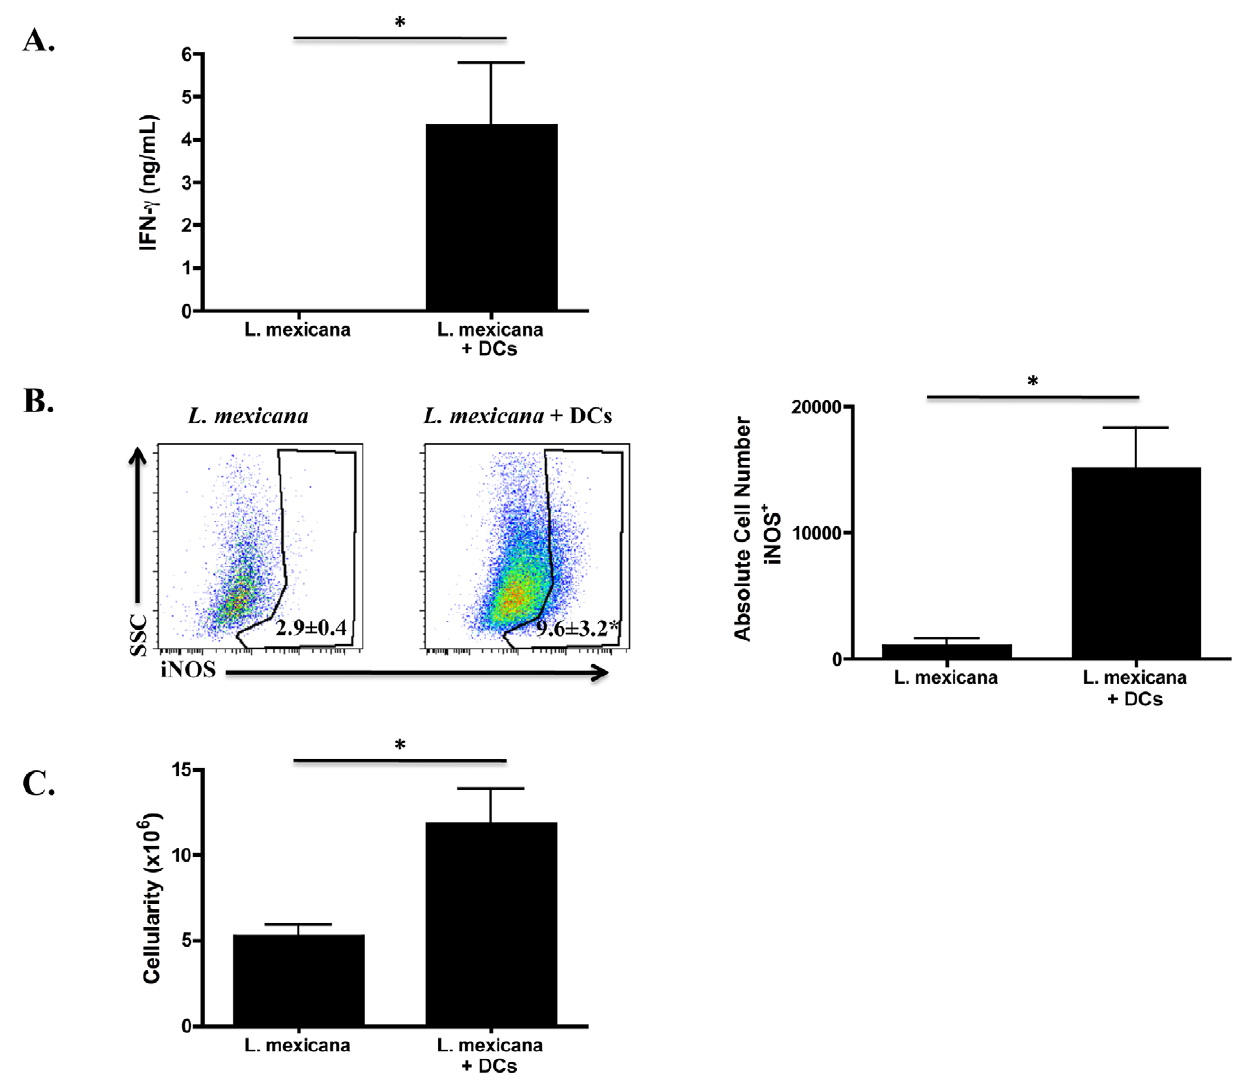
Figure 7. DCs injected at the time of infection with L.mexicana lead to a more robust Th1 response. C57BL/6 mice were infected as before in the ear with L. mexicana , however, one group also received DCs that were derived in vitro. At two weeks post-infection ears and dLNs were processed. ( A ) Levels of IFN- c (ng/mL) from the supernatants of single cell suspensions from the dLN of each group that were stimulated for 72 hours with L. mexicana freeze-thaw antigen. ( B ) Percentage and absolute number of iNOS-producing cells in the ear of L. mexicana infected mice or L. mexicana infected mice that received DCs. Cells are previously gated on live, singlets that are CD11b hi CD11c + . ( C ) The cellularity of the dLN in L. mexicana infected mice or L. mexicana infected mice that received DCs. The results expressed are the mean percentage ( 6 SD for FACS plots) or the mean number of cells ( 6 SE for bar graphs) of 2–4 mice per group. The results are representative of two experiments. * significantly higher (p , 0.05) compared to L. mexicana infected